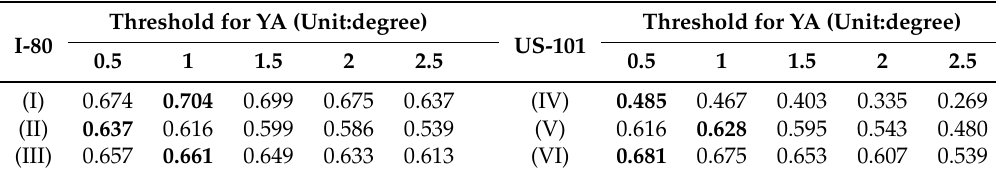
Table 3. Parameter comparison for yaw rate to the road tangent ϕ YA .